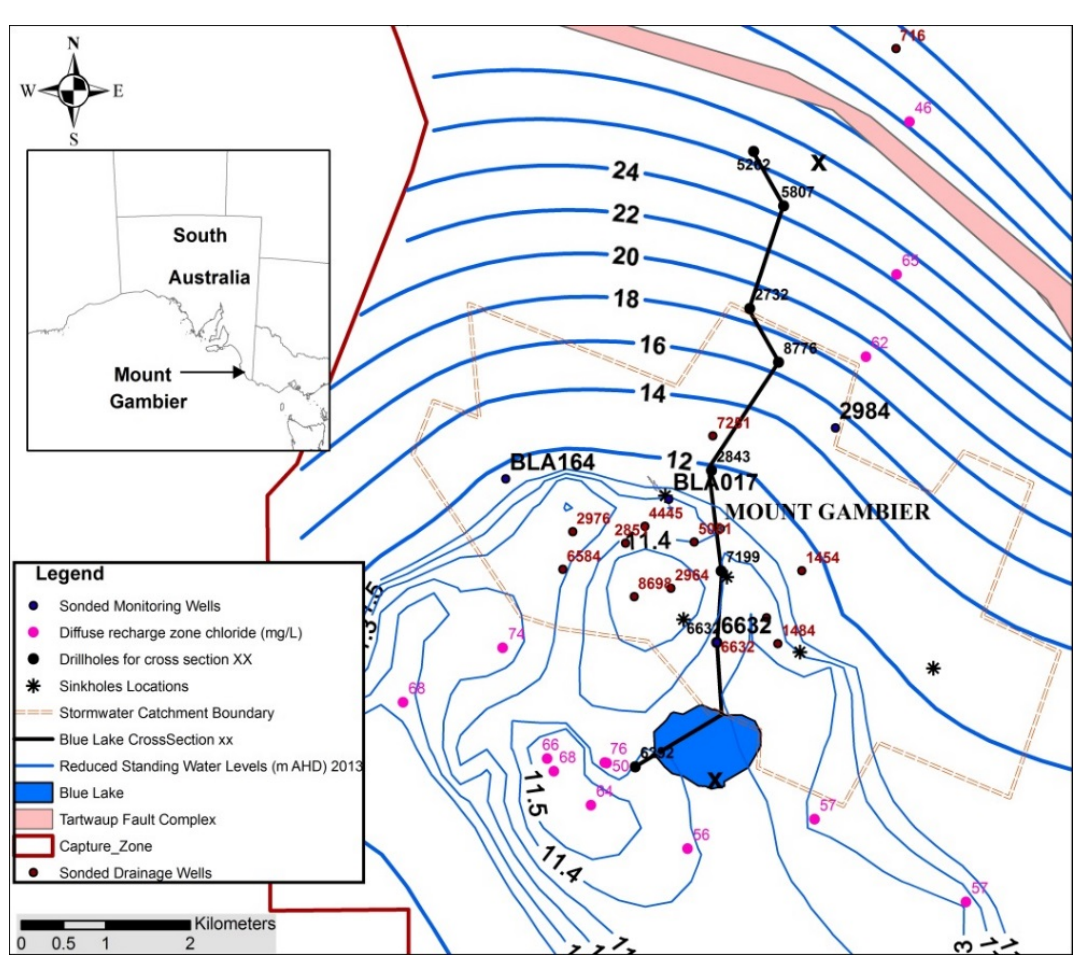
Figure 5. Mount Gambier city area of the Blue Lake capture